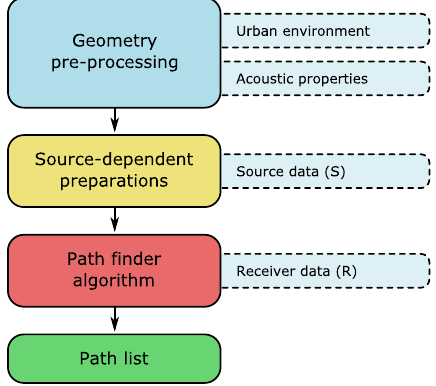
Figure 6. Block diagram of the construction of propagation paths (path fi